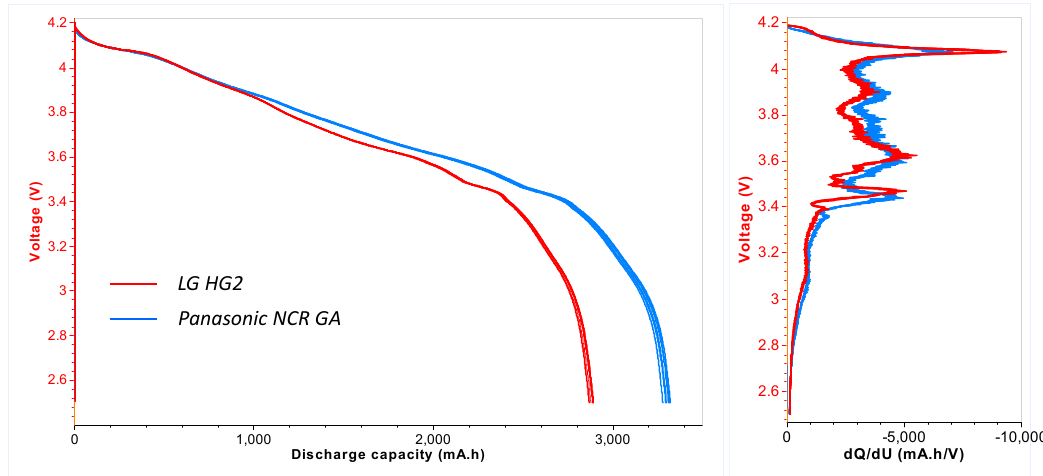
Figure 5. The actual discharge capacity profiles ( left ) and the differential capacity curves (voltage vs. dQ/dU) ( right ) of the selected technologies in their pristine states (plot of 6 cells for each technology, obtained from C/20 tests using the Electrochemistry Bio-Logic science instrument and EC-Lab software).